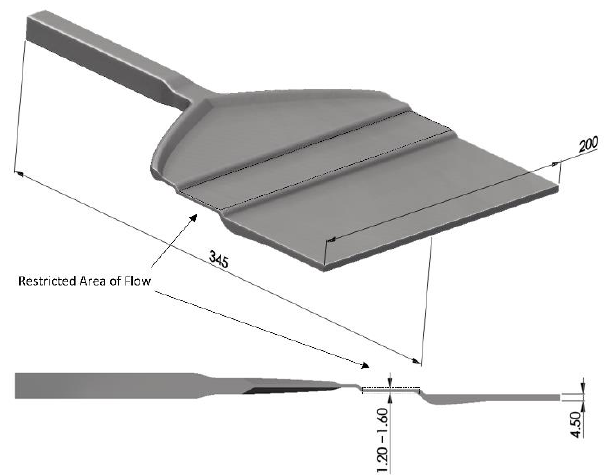
Figure 3. Schematic representation of the three-dimensional flow domain and cross-section of the coathanger manifold.